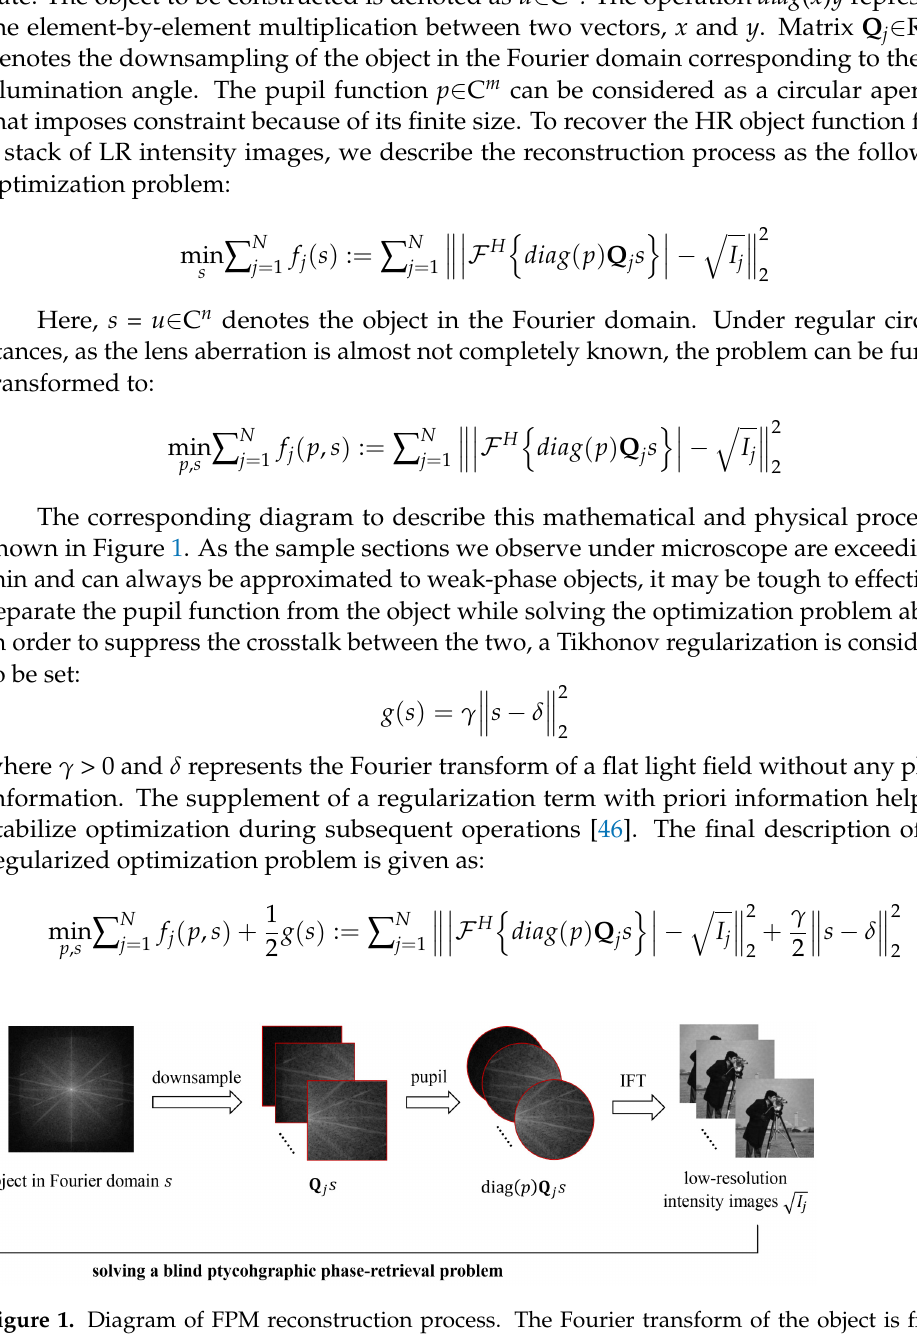
Figure 1. Diagram of FPM reconstruction process. The Fourier transform of the object is firstly downsampled by the illumination matrix, then confined by the pupil function and finally inverse Fourier transformed back to form LR intensity images in the spatial domain. The object is to be reconstructed by solving a blind phase retrieval problem.